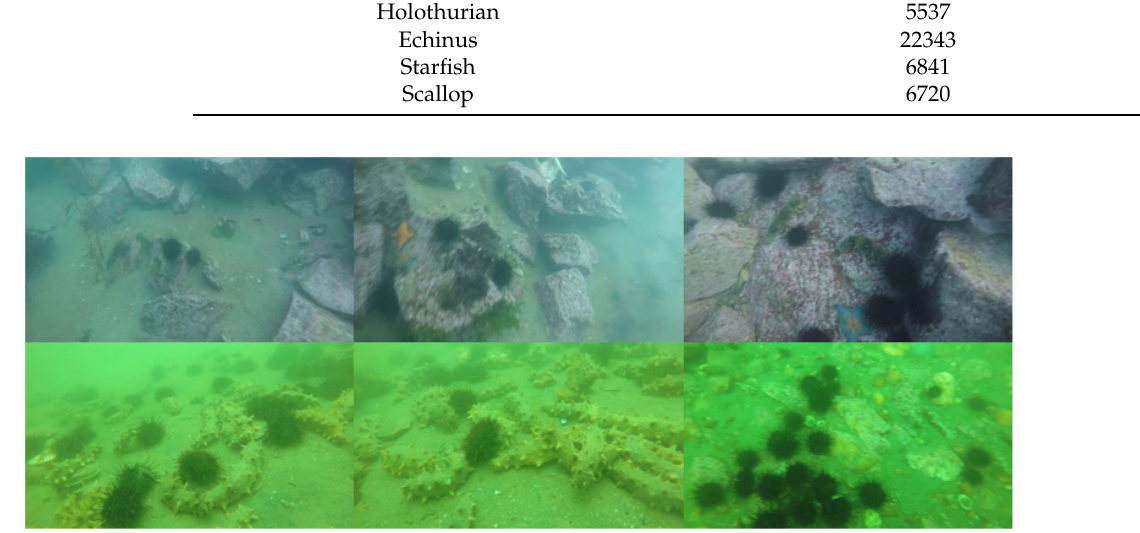
Figure 9. Training images from the URPC 2020.